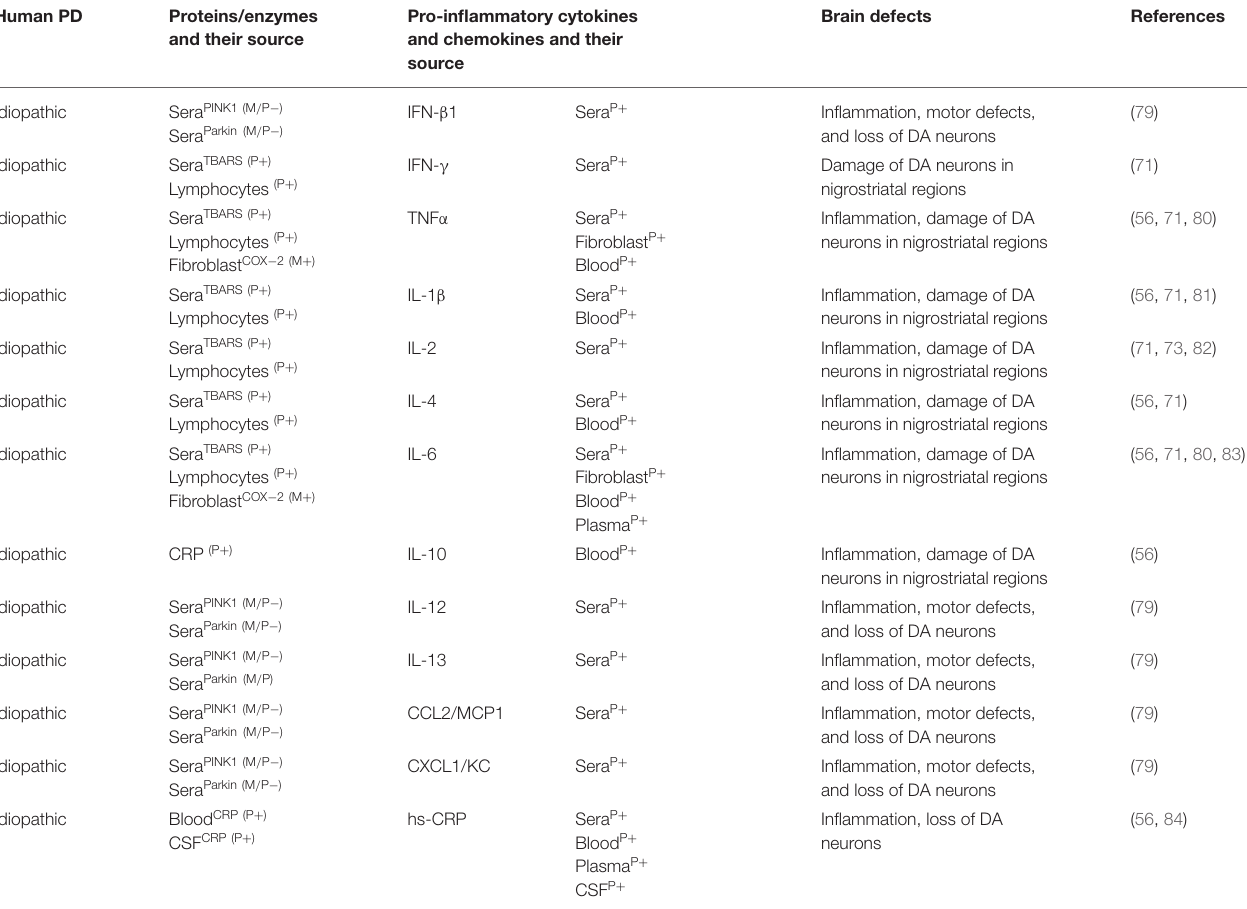
TABLE 1B | Cytokines and their source in idiopathic human PD. Human